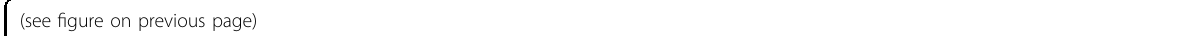
Fig. 6 The effects of CISD1 overexpression on mitochondrial function and neuron injury induced by OGD in vitro. A Neurons were stained by Tuj1, ROS, Mito tracker, and TUNEL to detect the condition of neurons, the level of ROS, the condition of mitochondria and neurons apoptosis in normal group, OGD group, si-NC group, ORF-NC group, si- CISD1 , and ORF- CISD1 group. Scale bar = 100 μ m (Mito tracker: scale bar = 50 μ m). B The bar charts of neurons viability in neurons of each group. Compared with normal group, the neurons viability decreased in OGD group. While the neurons viability increased in ORF-CISD1 group, compared with OGD group. C The level of ROS in neurons of each group. ROS signi fi cantly increased in OGD group, compared with the normal group. Whereas ROS decreased signi fi cantly in ORF-CISD1 group, compared with OGD group. D The mitochondria mean fl uorescence in neurons of each group. Mito mean fl uorescence signi fi cantly decreased in OGD group, compared with normal group. Whereas mito mean fl uorescence signi fi cantly increased in ORF-CISD1 group, compared with OGD group. E Percentage of TUNEL/DAPI of neurons was shown in each group. TUNEL staining was used to analyze neuronal apoptosis. The percentage of TUNEL/DAPI signi fi cantly increased in OGD group, compared with normal group. Whereas percentage of TUNEL/DAPI signi fi cantly decreased in ORF-CISD1 group, compared with OGD group. The data were presented as the mean ± s.d. ** P < 0.01 with one-way ANOVA, n = 6. CISD1 CDGSH iron sulfurdomain-containing protein 1, OGD oxygen glucose deprivation, HI hypoxia ischemia, ROS reactive oxygen species, ORF- CISD1 CISD1 overexpression, si- CISD1 CISD1 low expression, ORF-NC negative control overexpression, si-NC negative control low expression, Tuj1 neuronal class III β -tubulin, TUNEL terminal deoxynucleotidyl